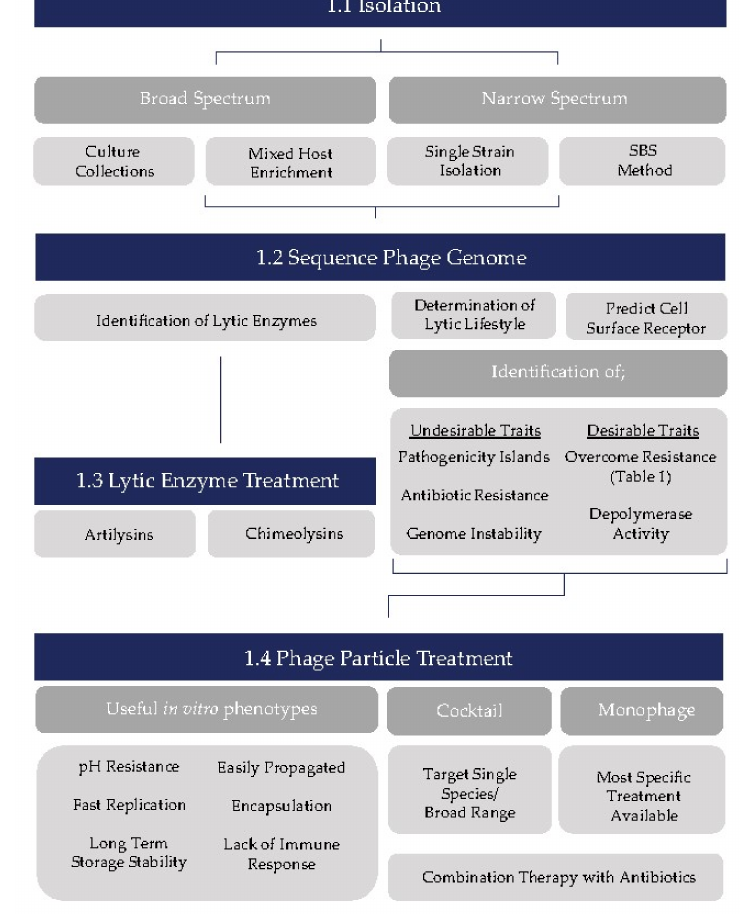
Figure 1. Suggested workflow for selection of phage therapy candidates, from isolation to implementation including desirable in vitro